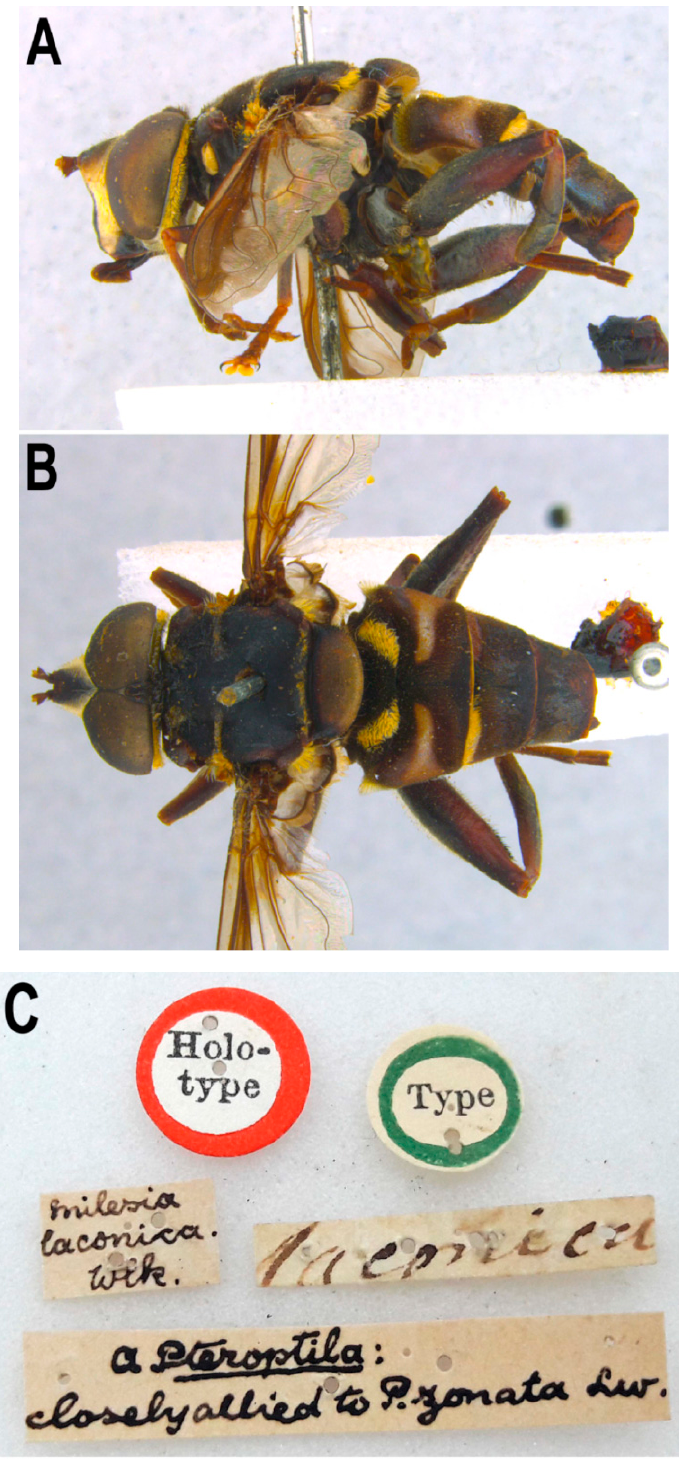
Figure 13. Meromacrus laconicus , adult, male holotype. ( A ): entire body, lateral view. ( B ): body, dorsal view. ( C ): specimen labels.